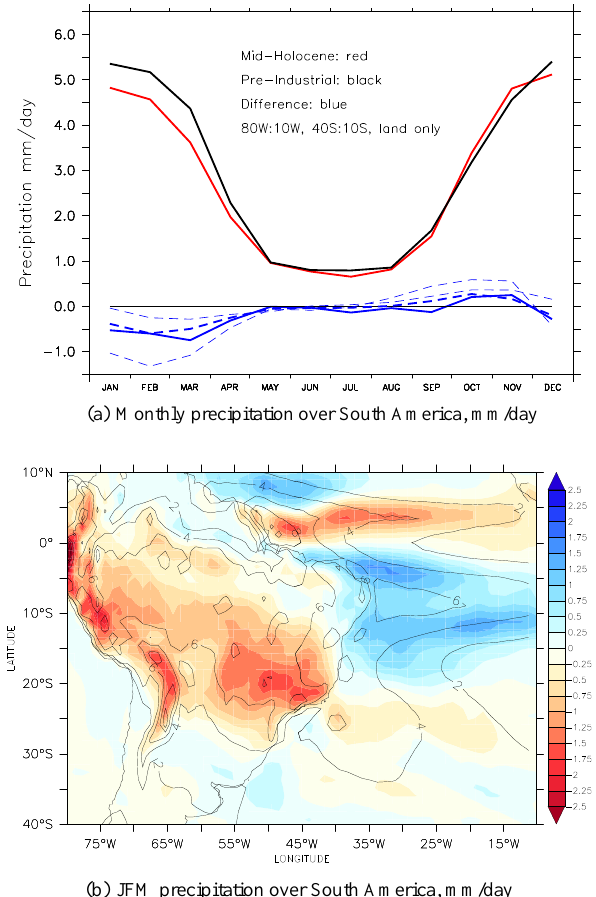
(a) Evaporation, mm/day (colours) and wind speed, m/s (contours), (b) Vertical velocity (omega) at 500hPa, hPa/s both are MH-PI differences Fig. 11. MH - PI JAS differences in (a) evaporation (colours, mm/day) and wind speed (contours, m/s), (b) vertical velocity at 500hPa in hPa/s (negative values indicating upward motion), contours are PI values. 500 hPa is approximately 500 km.